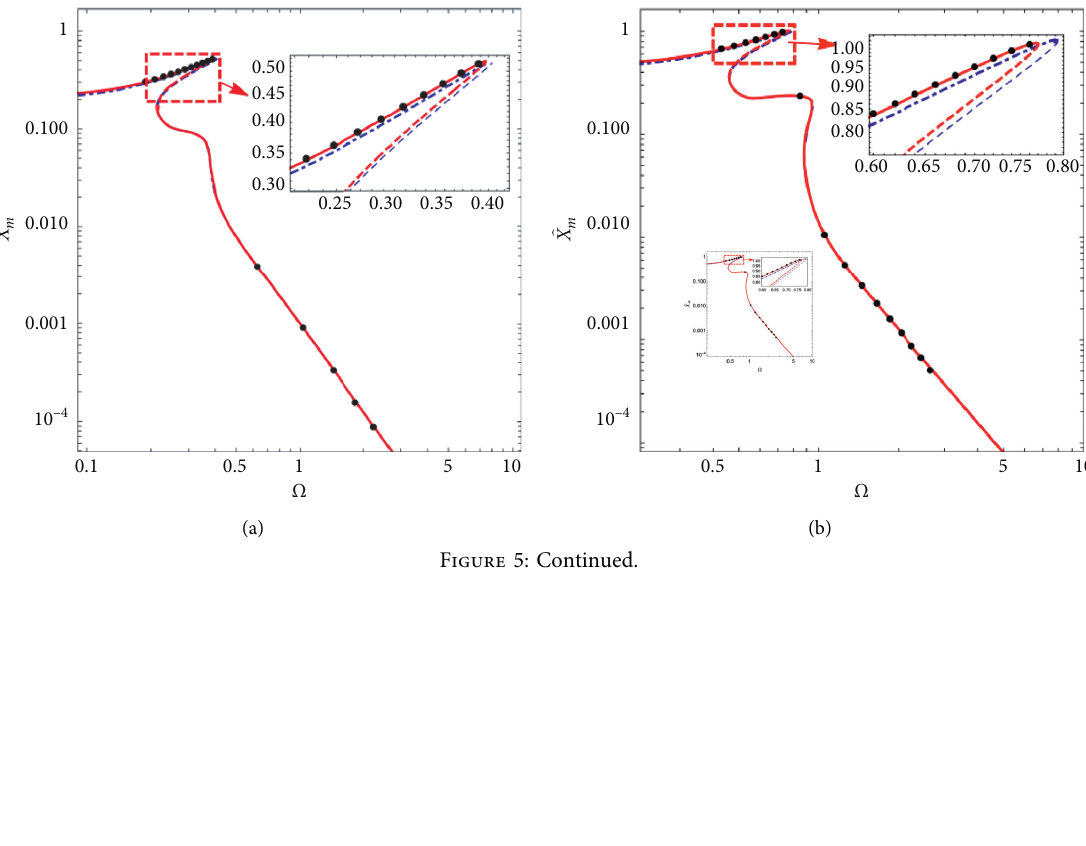
s 1 and m s 2 when μ � 1, and (d) 􏽢 F e